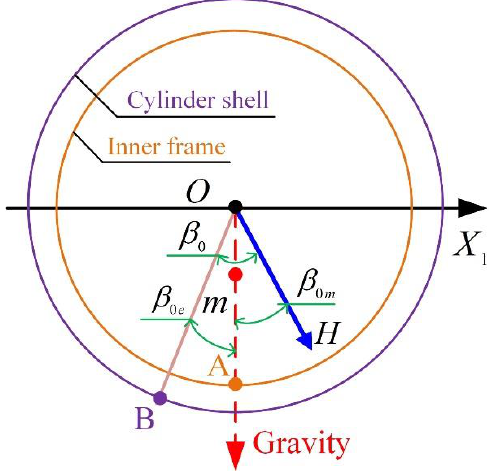
Figure 7. Illustration of zero offset.